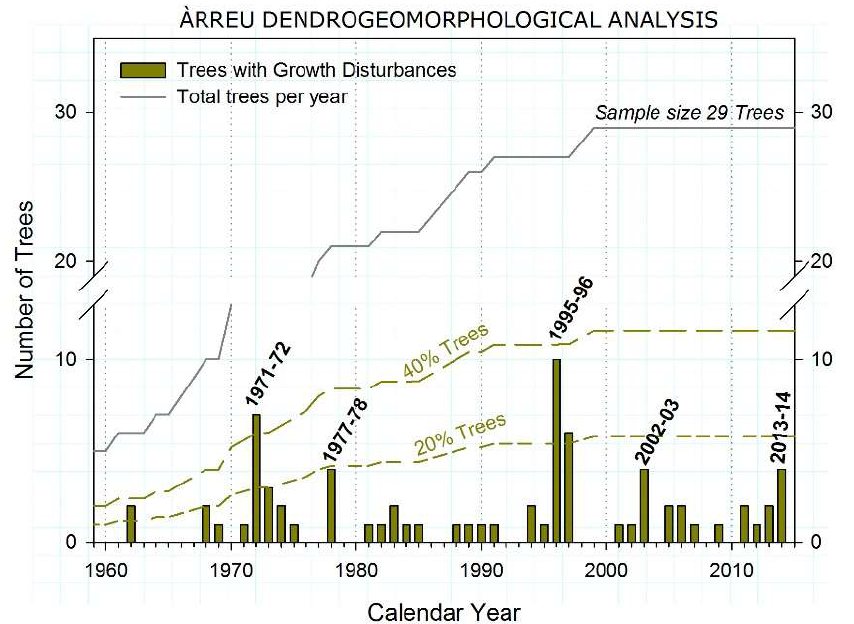
Figure 10. Results from the dendrogeomorphological analysis. The number of trees with GD per year is represented in bars. The lines symbolize the total number of sampled trees (gray line), 20% and 40% of the total trees (green dashed lines). Winters considered avalanche years are indicated (modified from [4]). (In this study, GD trees were equally weighed in the calculation despite the number of tree-ring signals in one year or the intensity of the signals.) Table 1. Estimated return period of the registered avalanches.